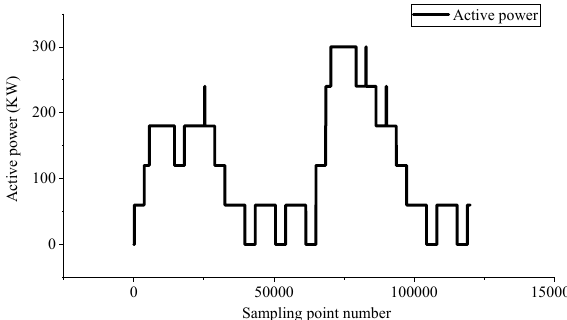
Figure 4. Electric vehicle charging station power–time curve.